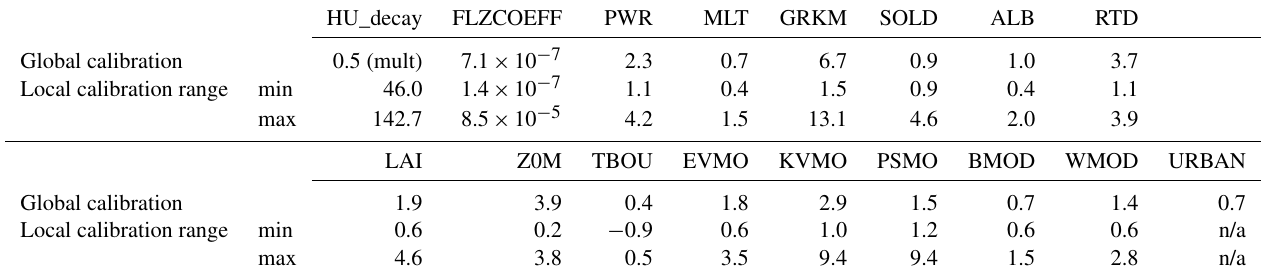
Table 4. Final parameter values or ranges after calibration; for global calibration, HU_decay consists of a multiplicative coefficient. See Table 2 for parameter definition. n/a: not